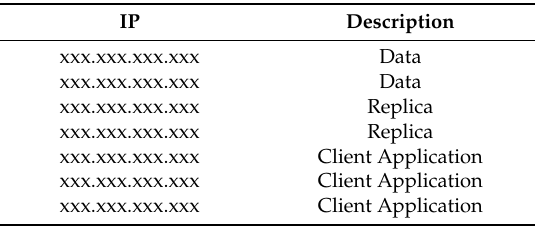
Figure 3. System data storage device architecture. Table 1. System data file containing registered IP list